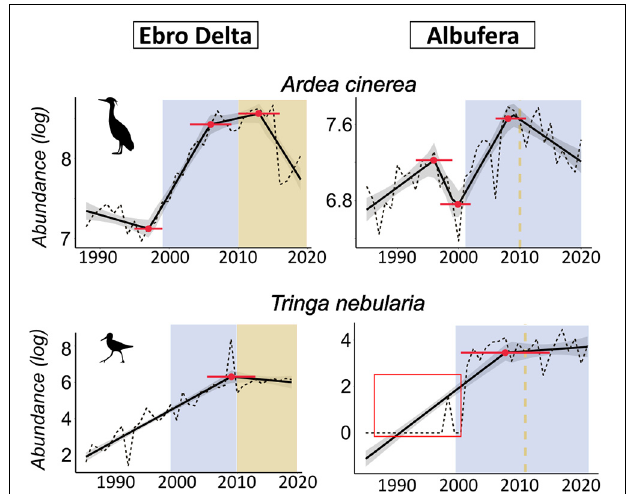
FIGURE 4 | Estimated trends in Ardea cinerea and Tringa nebulosa abundance and years of change. For details on plot elements see the legend of Figure 3 . For details on model outputs see Supplementary Figure 3 and Supplementary Table 1